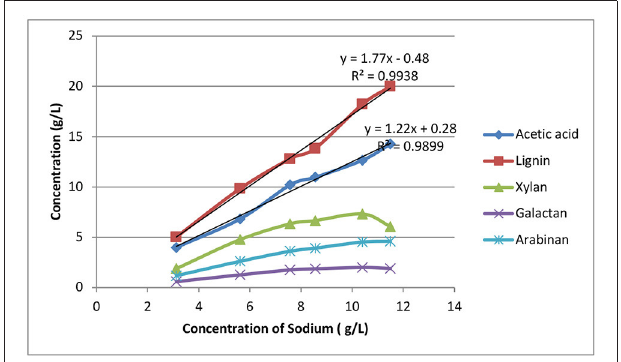
FIGURE 7 | The correlation between weak black liquor recycle and sodium and organic substances extracted from fresh biomass.